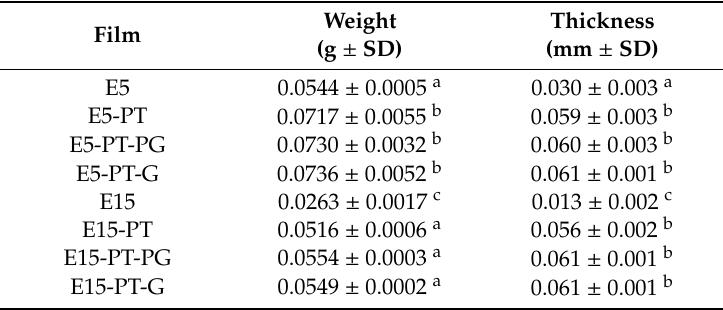
Table 3. Weight and thickness of 3D-printed